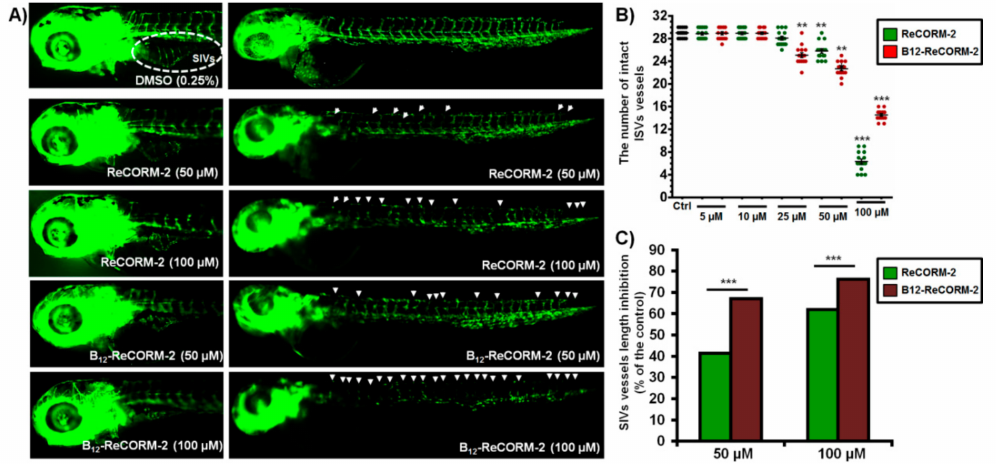
Figure 7. The suppression of neovascularization in developing zebrafish embryos by ReCORM-2 and B 12 -ReCORM-2 treatments assessed according to the ISV vessel development at 48 hpf and the SIVs vessel development at 72 hpf. Treatments’ e ff ect on the fluorescently labeled vasculature in Tg ( fli1 :EGFP) embryos was shown ( A ). The tested compounds achieved a dose-dependent inhibition of the ISV vessel development, compared to the ISVs number in the control group ( B ); the e ff ect on the SIVs basket development was the most pronounced at the doses ≥ 50 µ M ( C ). ** p < 0.01; *** p <